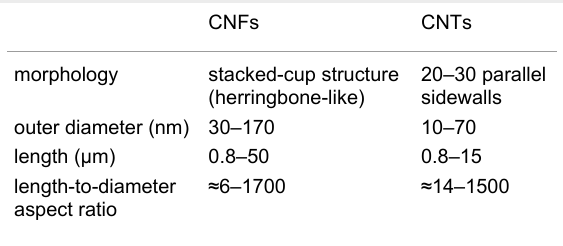
Table 4: Physico-chemical properties of the tested carbon nanomateri- als as determined previously [13,28].